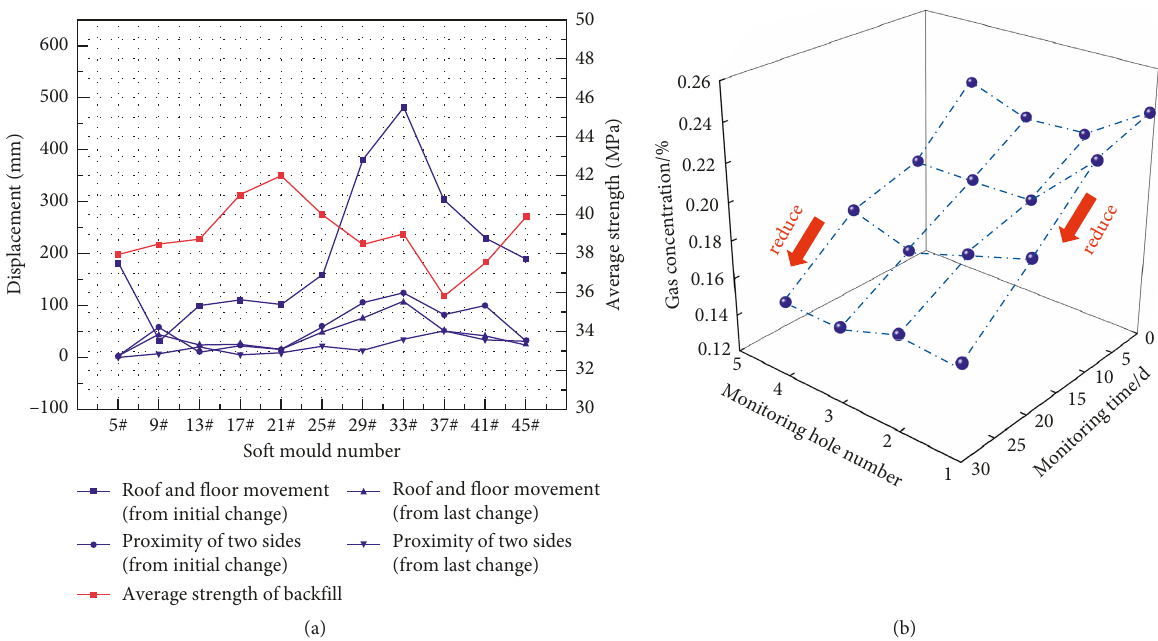
Figure 8: Analysis of monitoring results. (a) Displacement value. (b) Gas